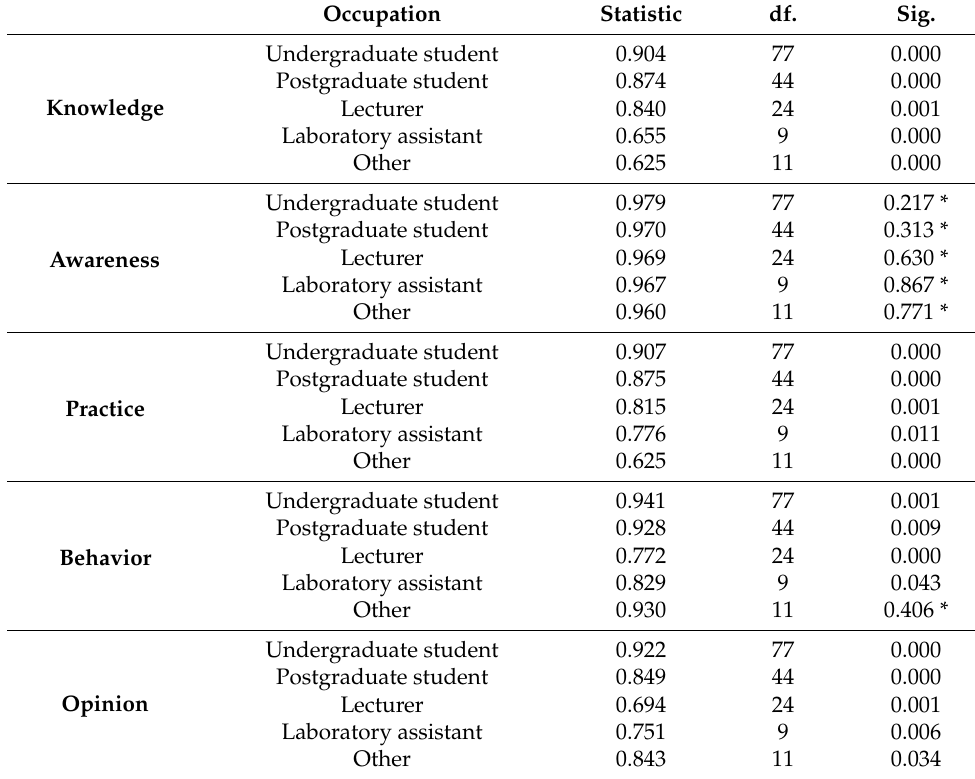
Table 6. Normality test analysis using Shapiro–Wilk